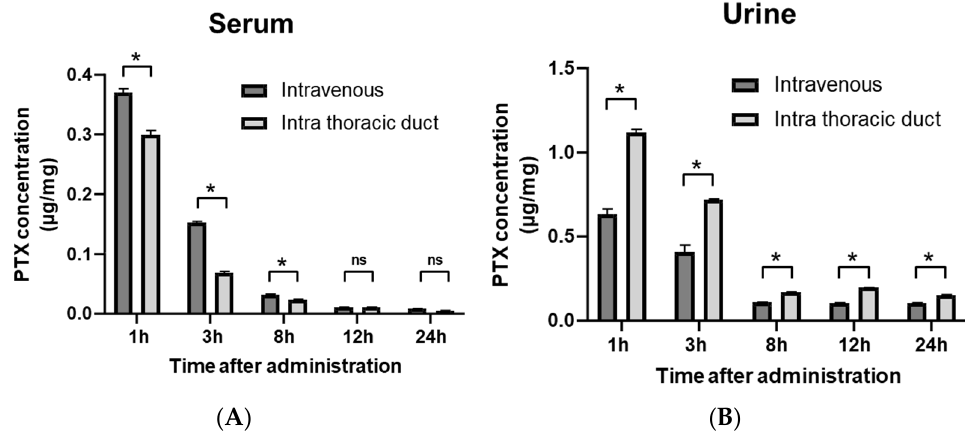
Figure 3. PTX concentrations in serum ( A ) and urine ( B ) after IT or IV injection. Serum and urine samples were obtained 1 to 24 h after infusion. PTX concentrations were measured with a mass spectrometer (LC-MS/MS). Data show the mean ± SD of 3 experiments. *: p < 0.01, ns: not significant.